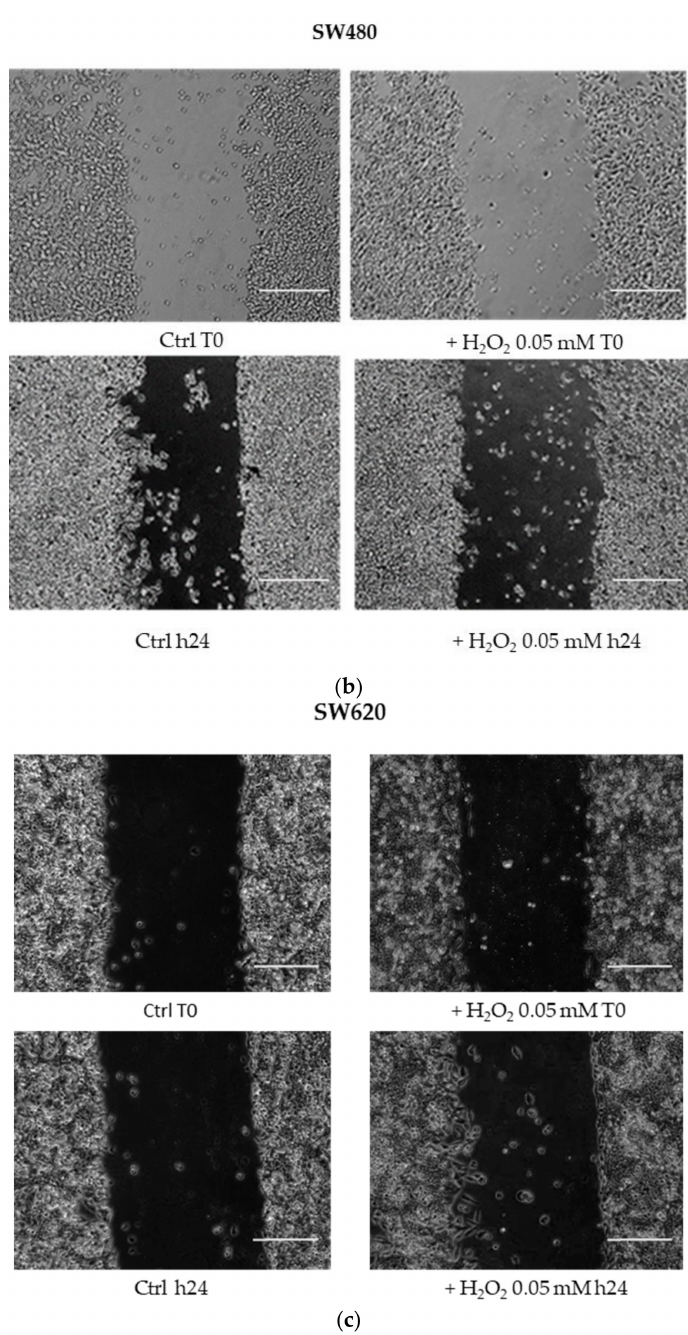
Figure 4. Wound healing assay. Cell migration was determined by in vitro closure of scratch area after 24 h 0,05 mM H 2 O 2 treatment in the absence of serum: ( a ) HCT116 cells, ( b ) SW480 cells, ( c ) SW620 cells. Images were captured by a camera coupled to the EVOSTM XL Core Imaging System microscope (Thermo Fisher), with 10 × magnification, before (time-0) and after 24 h of treatment, and compared to control without H 2 O 2